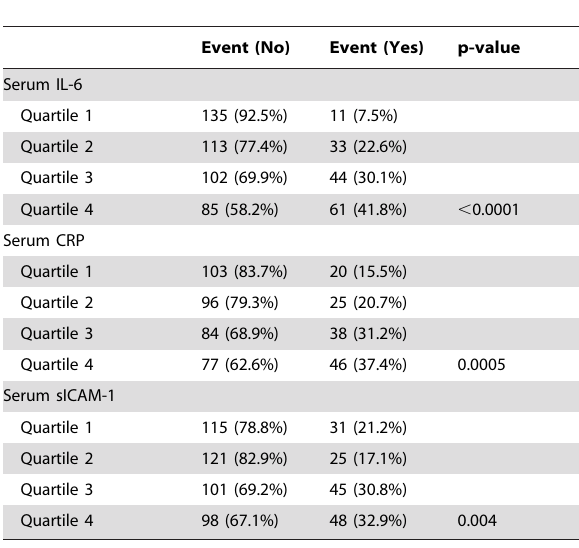
Table 7. Hazard Ratios for COPD Related Events adding Serum